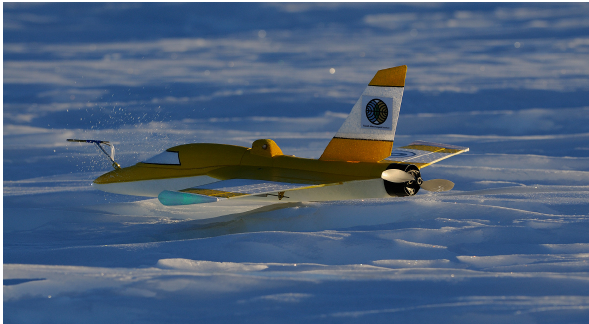
Figure A1. Small Unmanned Meteorological Observer (SUMO), which is used to measure vertical profiles of air temperature, humid- ity, and wind speed up to the height of 2–3km. Photo: Priit Tisler, Finnish Meteorological